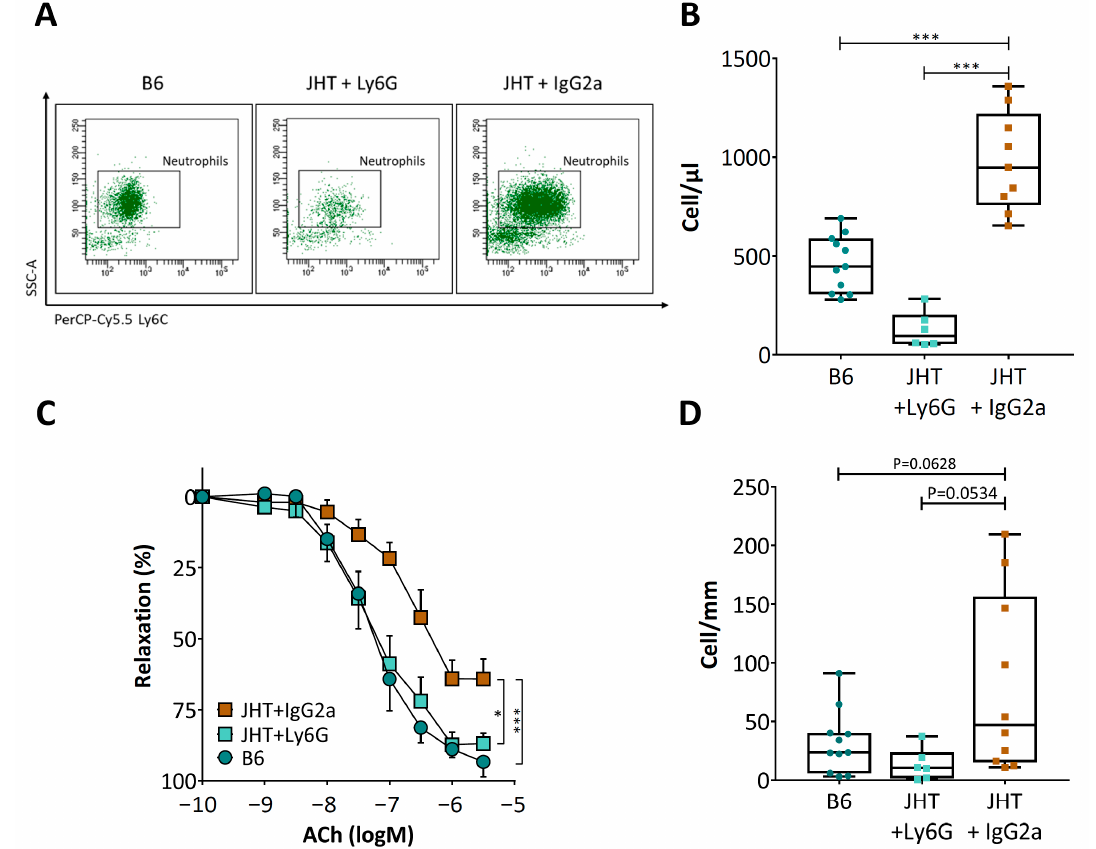
Figure 5. Neutrophil depletion restores vascular function in JHT mice. Ten-week-old JHT mice were treated intraperitoneally with anti-Ly6G antibody to deplete neutrophils. IgG2a served as isotope control. 36 h after antibody injection, neutrophil numbers were quantified in the circulating blood ( A , B ) and aorta (including aortic PVAT) with FACS. Vascular function was studied using a wire myograph system ( C ). The boxes in panels B and D represent the interquartile range (IQR) which contains data between the 25th and 75th percentiles. The whiskers represent the minimum and maximum values. The horizontal lines within the boxes are the medians ( B , D ). Symbols in panel C represent mean ± SEM; n = 9. * p < 0.05, *** p < 0.001; two-way ANOVA.